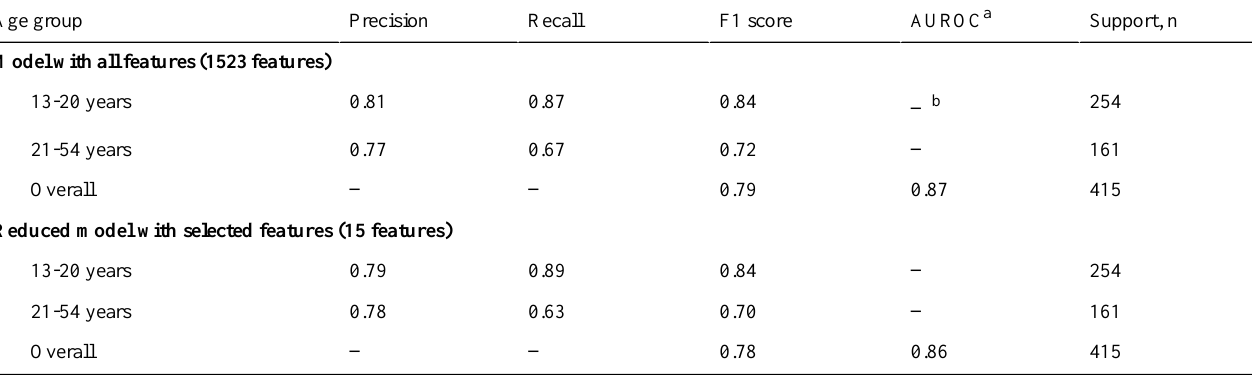
Table 4. Model performance on the test set for predicting age group of Reddit users using gradient boosted trees classifier with all features vs select